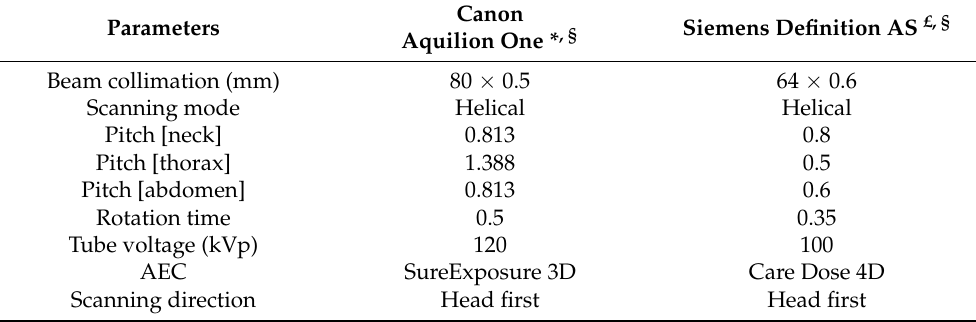
Table 1. CT scanning